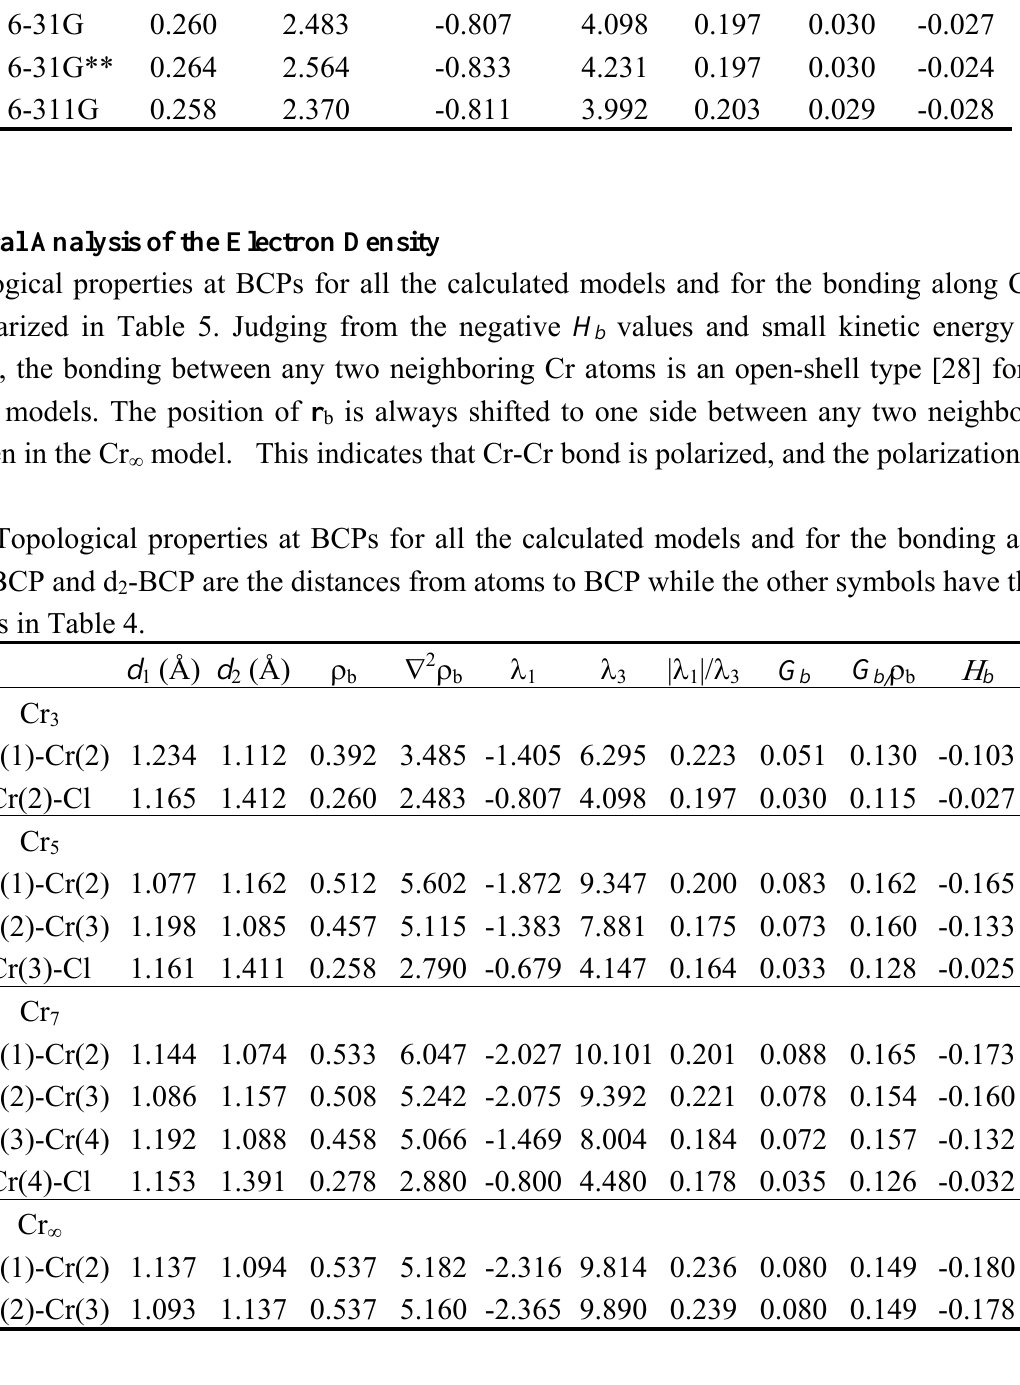
Table 4 Topological properties associated with the bond critical point in the bonding of Cr axis direction for the different basis sets, where λ , λ and λ are the eigenvalues of the hessian matrix 1 2 3 of ρ ; ρ , H , G and ∇ 2 ρ are the electron density, the total energy density and the Laplacian at the b b b b BCP accordingly. The units for G and H are Hartree/ Å 3 b b